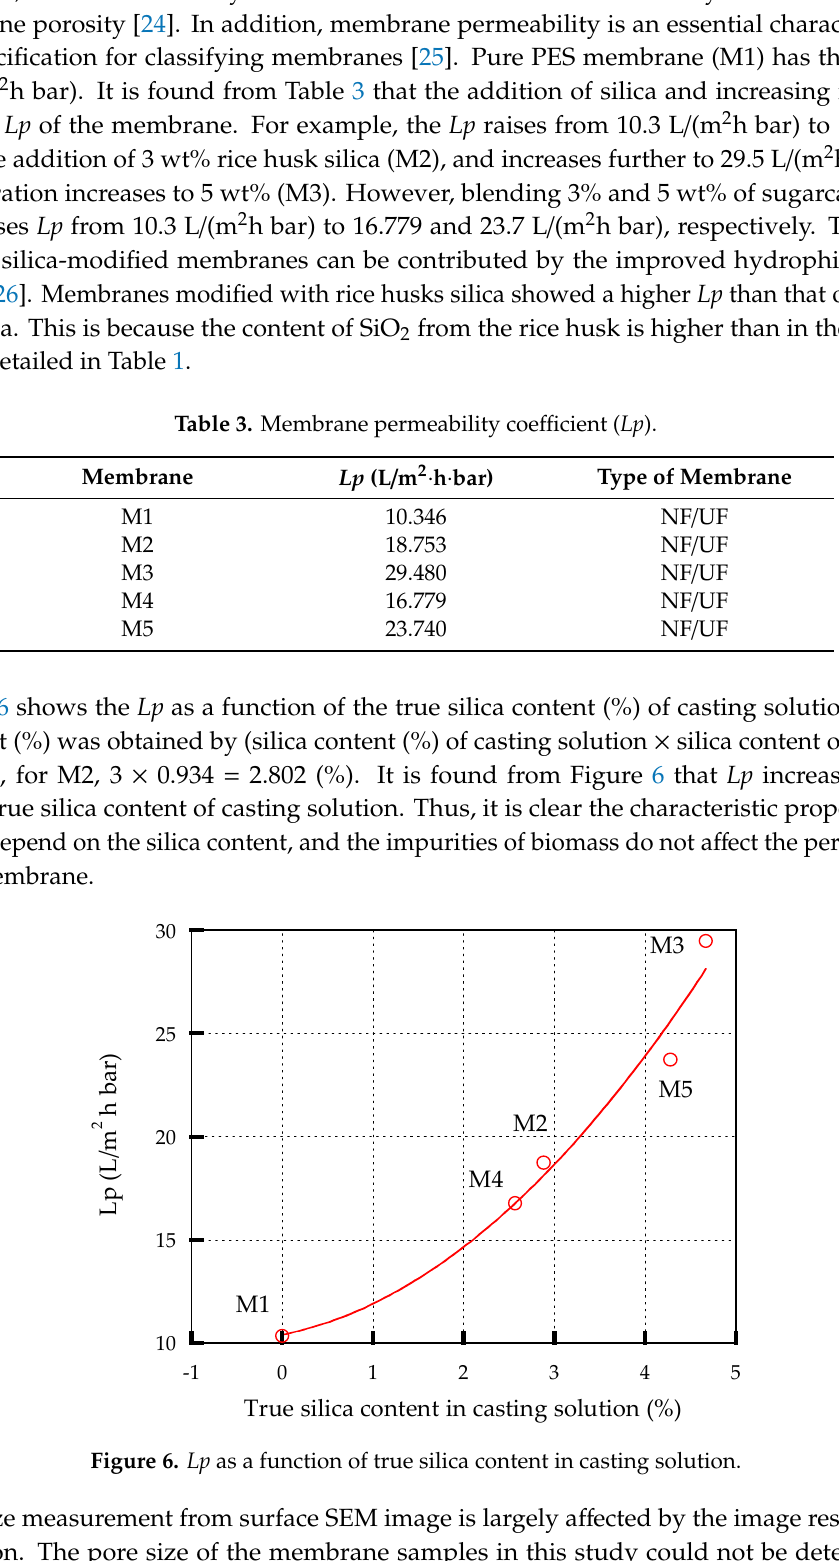
Table 3. Membrane permeability coefficient ( Lp ).